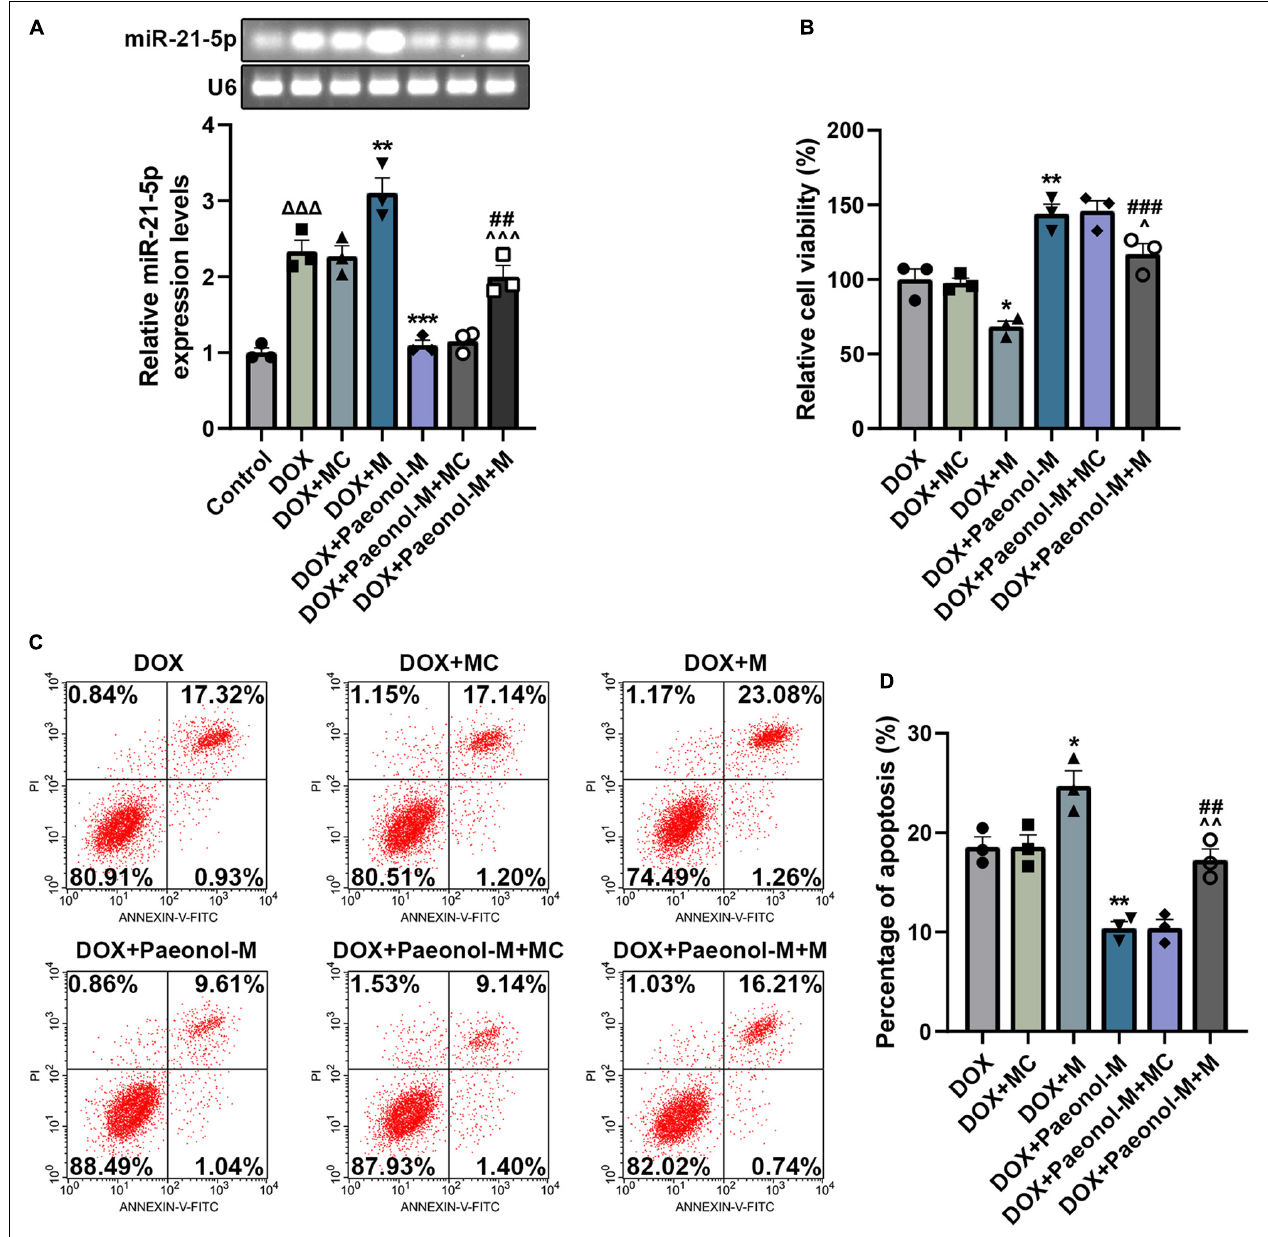
FIGURE 4 | miR-21-5p mimic counteracted the effects of paeonol on the viability, apoptosis, and miR-21-5p expression of the DOX-induced cardiomyocytes. (A) The expression of miR-21-5p in DOX-induced H9c2 cells treated with miR-21-5p mimic or paeonol-M was quantified by RT-qPCR. U6 served as an internal control. (B) The viability of DOX-induced H9c2 cells treated with miR-21-5p mimic or paeonol-M was detected by CCK-8 assay. (C,D) The apoptosis of DOX-induced H9c2 cells treated with miR-21-5p mimic or paeonol-M was unveiled using flow cytometry. * P < 0.05, ** P < 0.01, *** P < 0.001 vs. DOX +